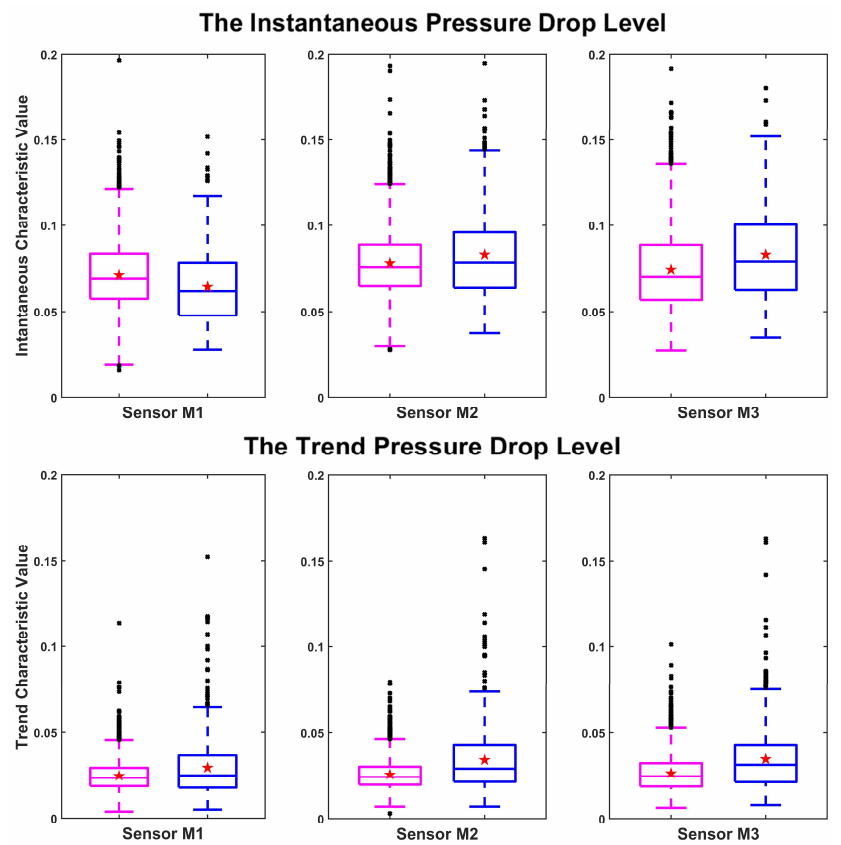
Figure 10. The distribution of pressure drop levels in leakage-free time series in two time series data